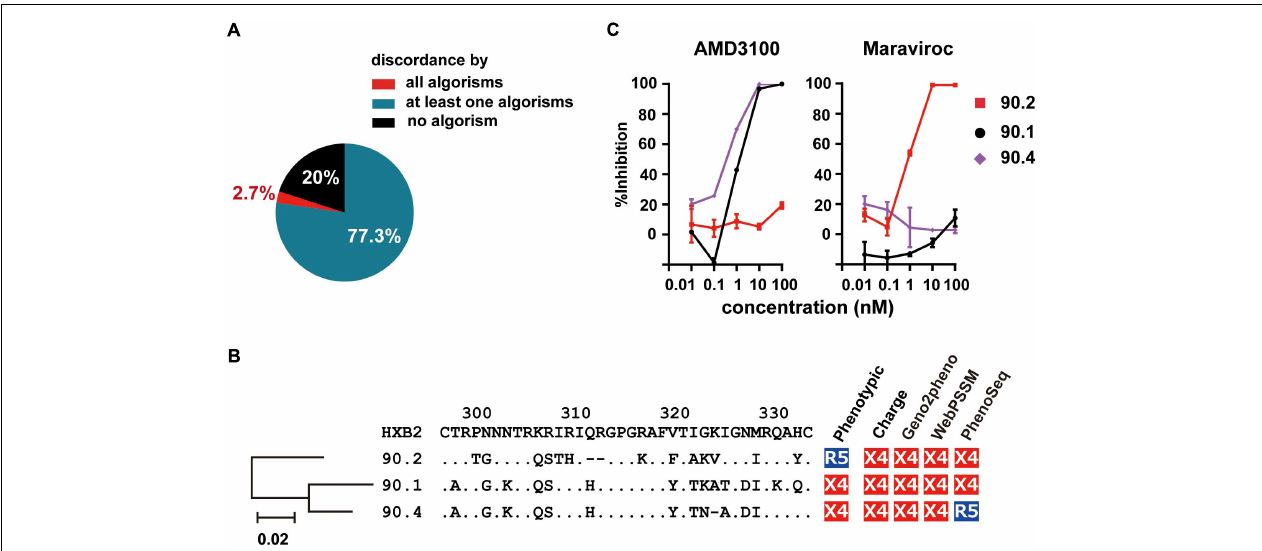
FIGURE 4 | Frequency of incorrect prediction among R5 envelope clones. (A) Pie chart showing the frequency of the clones correctly or incorrectly predicted by the genotypic algorithms. (B) Phylogenetic tree, amino acid sequences of V3 region, and co-receptor assignment by phenotypic and genotypic analysis of the indicated clones from patient NV90. (C) Sensitivity of lentivirus reporters pseudotyped with the indicated envelope clones toward the entry inhibitors, Maraviroc and AMD3100. Target cells were TZM-bl cells. The data represent the mean of triplicate assays.